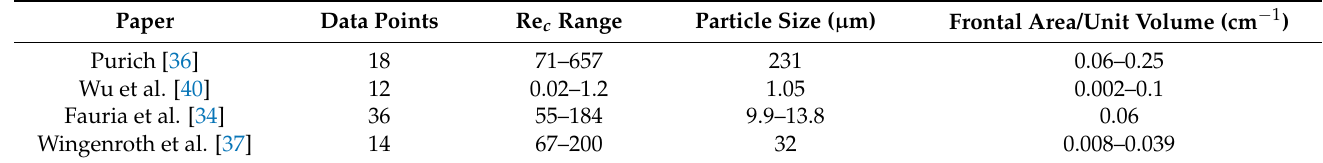
Table 1. Summary of training data used to fit the functional form presented in this paper. Re c , Reynolds number.